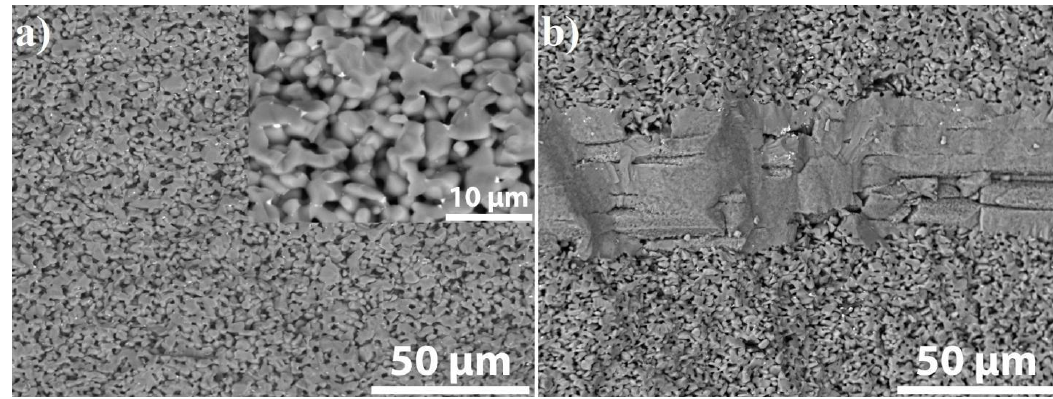
Figure 12. SEM images of the fracture surface of the fiber-free SiC ( a ) with magnified image (inset) and the SiC f /SiC p composite sintered at 40 MPa for 10 min ( b ).